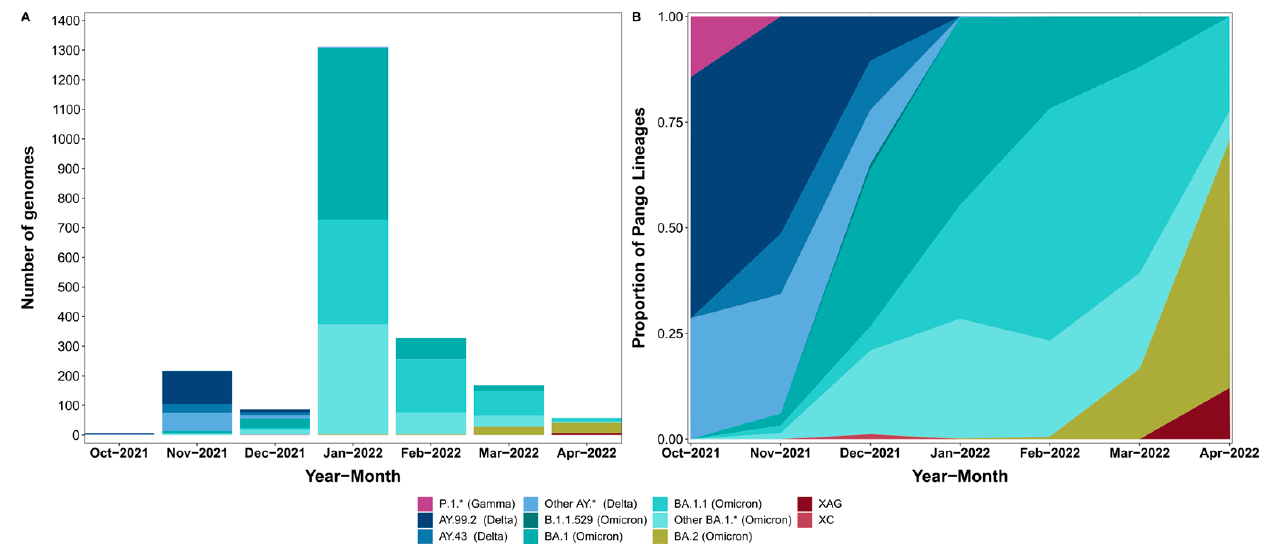
Figure 2. Distribution of SARS-CoV-2 lineages in this study from October 2021 to April 2022. In ( A ) is represented the absolute number of genomes by lineage and in ( B ), their relative frequency.